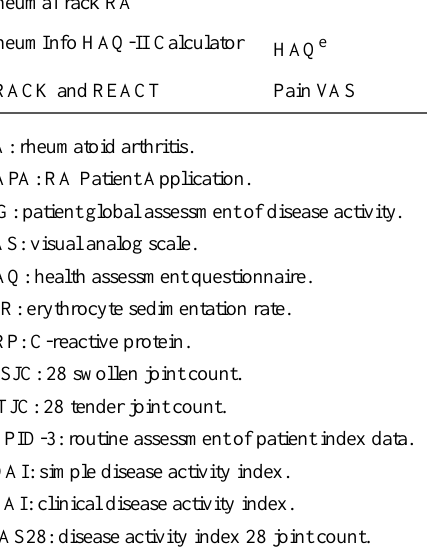
Allows users to record